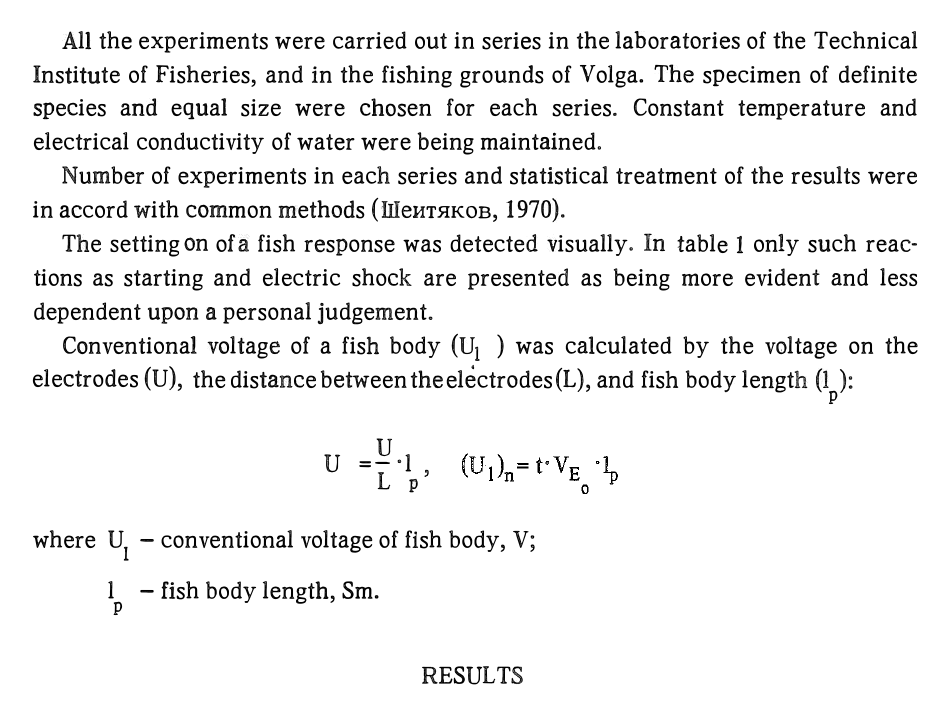
Table 1 data were used for drawing the graphs of relationship between the thershold values of fish body conventional voltage (U transformation on the electrodes (V electrodes (V ),